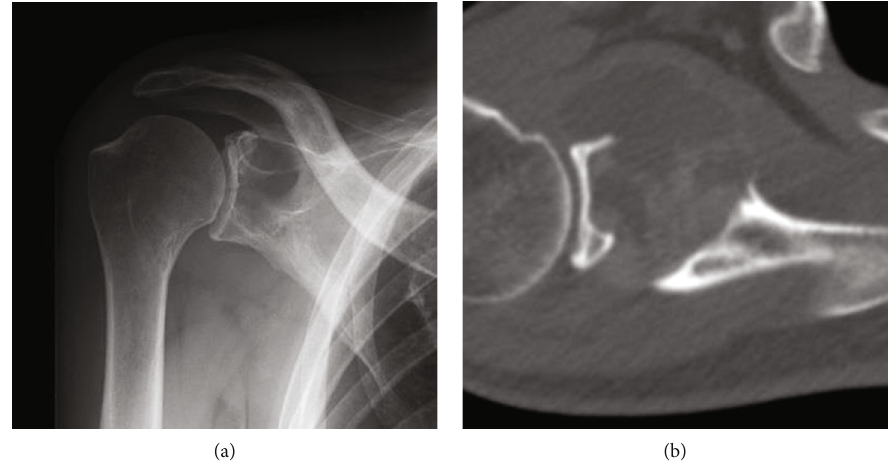
Figure 1: (a) Conventional radiograph of the right shoulder showing a lytic lesion involving the right scapula near the glenoid. (b) Computed tomography depicting the osteolytic lesion at the scapula with associated cortical destruction and extension into the surrounding soft